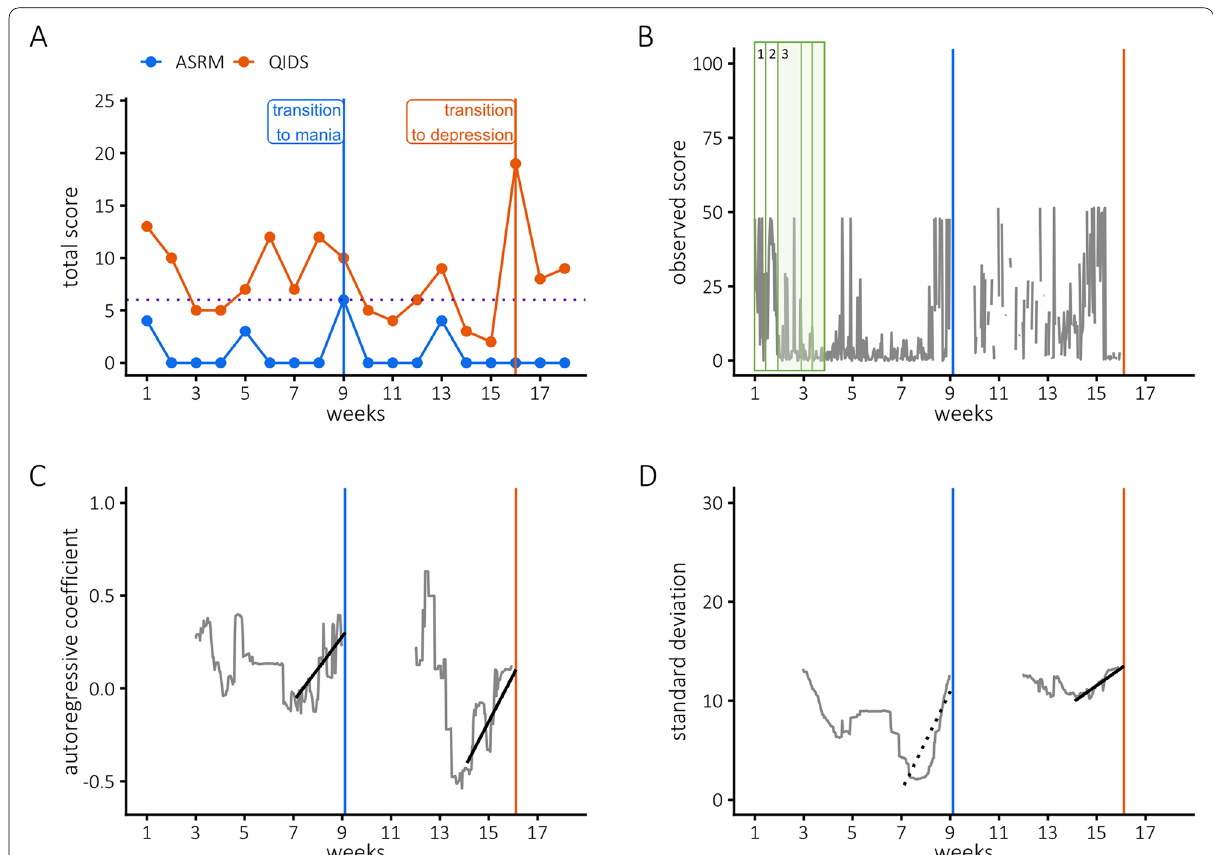
Fig. 1 An illustration of early warning signals in one individual (ID6) in the item “I feel extremely well”. A depicts weekly manic (Altman Self-Rating Scale, ASRM, blue) and depressive (Quick Inventory of Depressive Symptomatology, QIDS-SR, red) symptom scores. At week 8 and 15, she reports an abrupt transition to a manic and depressive episode, respectively. Figure 1B visualizes her raw ecological momentary assessment (EMA) scores on “feeling extremely well”. Higher scores indicate she is feeling more euphoric. We iteratively fitted windows containing two weeks of observations (green rectangles). These windows slided through the time series, meaning that the first window contained observations 1–70, the second window contained observations 2–71, etc. Note that the windows in the figure solely serve to illustrate the main idea behind the analyses. Within each window, we computed the autocorrelation and standard deviation as early warning signals (EWS). This yielded surrogate time series of the autocorrelation and standard deviation. As shown in Fig. 1C, significant EWS were found prior to the manic transition (Kendall’s Tau .54, corrected = p < .001) as well as the depressive transition (Kendall’s Tau .68, corrected p < 0.001). Figure 1D shows an EWS in the standard deviation prior to the = depressive transition (Kendall’s Tau .75, corrected p < 0.001), but not prior to the manic transition (Kendall’s Tau .50, corrected p = = =